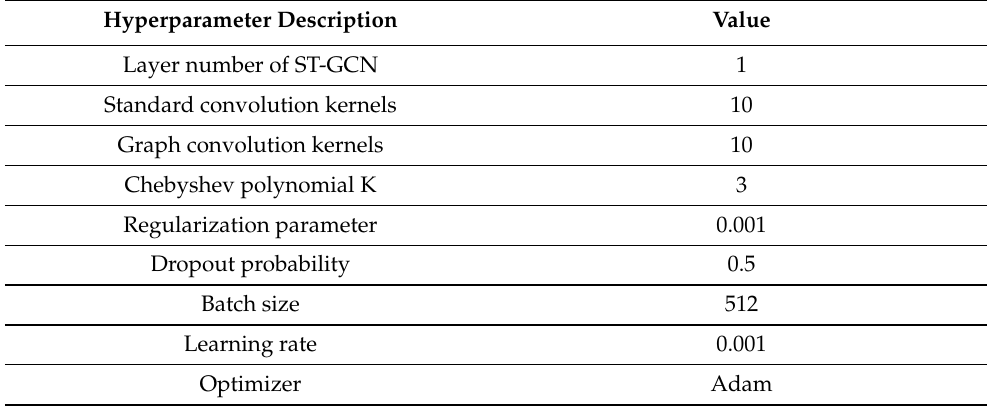
Table 4. Hyperparameters in the model that predicts emotions to Circumplex